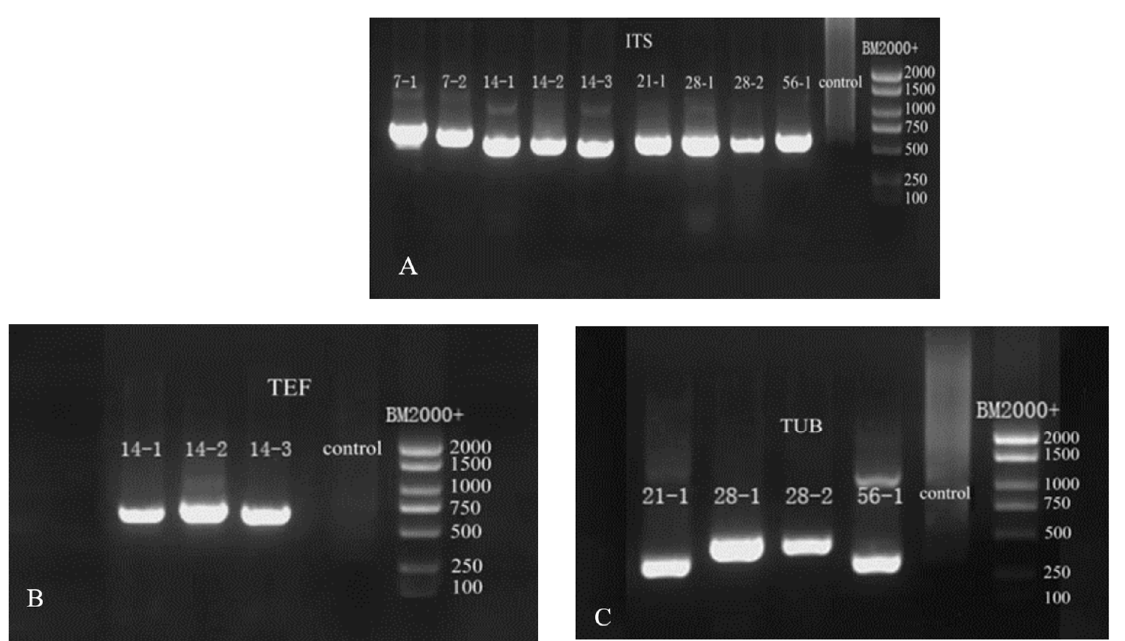
Figure 5. Gel electrophoresis images of PCR amplification products. ( A ): ITS gel electrophoresis images; ( B ): TEF gel electrophoresis images; ( C ): TUB gel electrophoresis images.